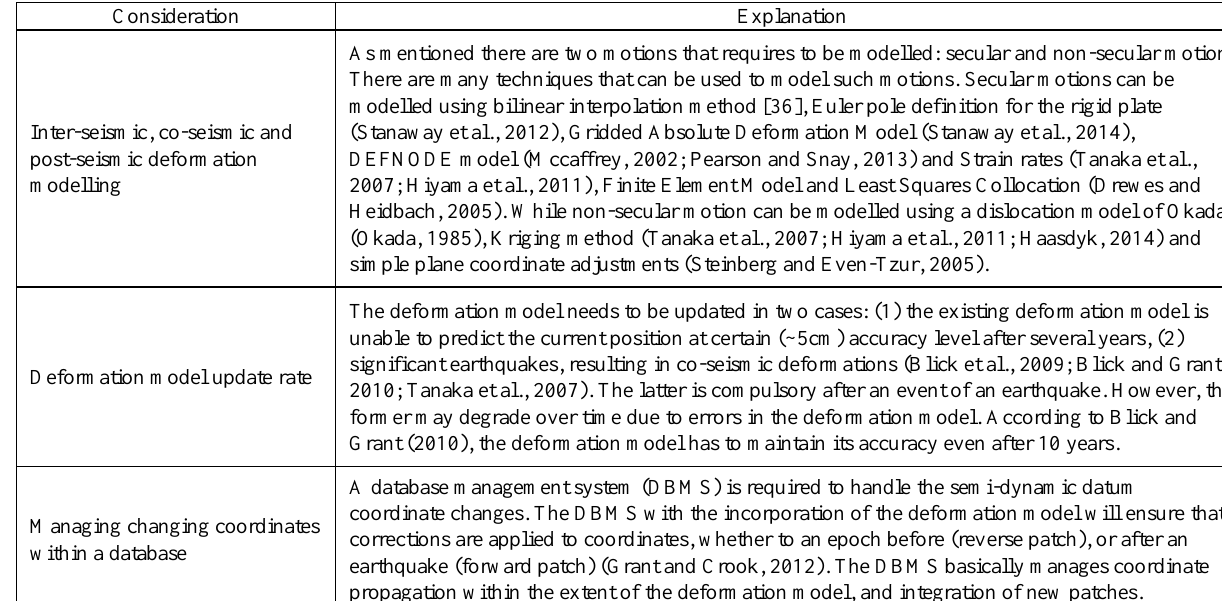
Table 2. Considerations for developing a deformation